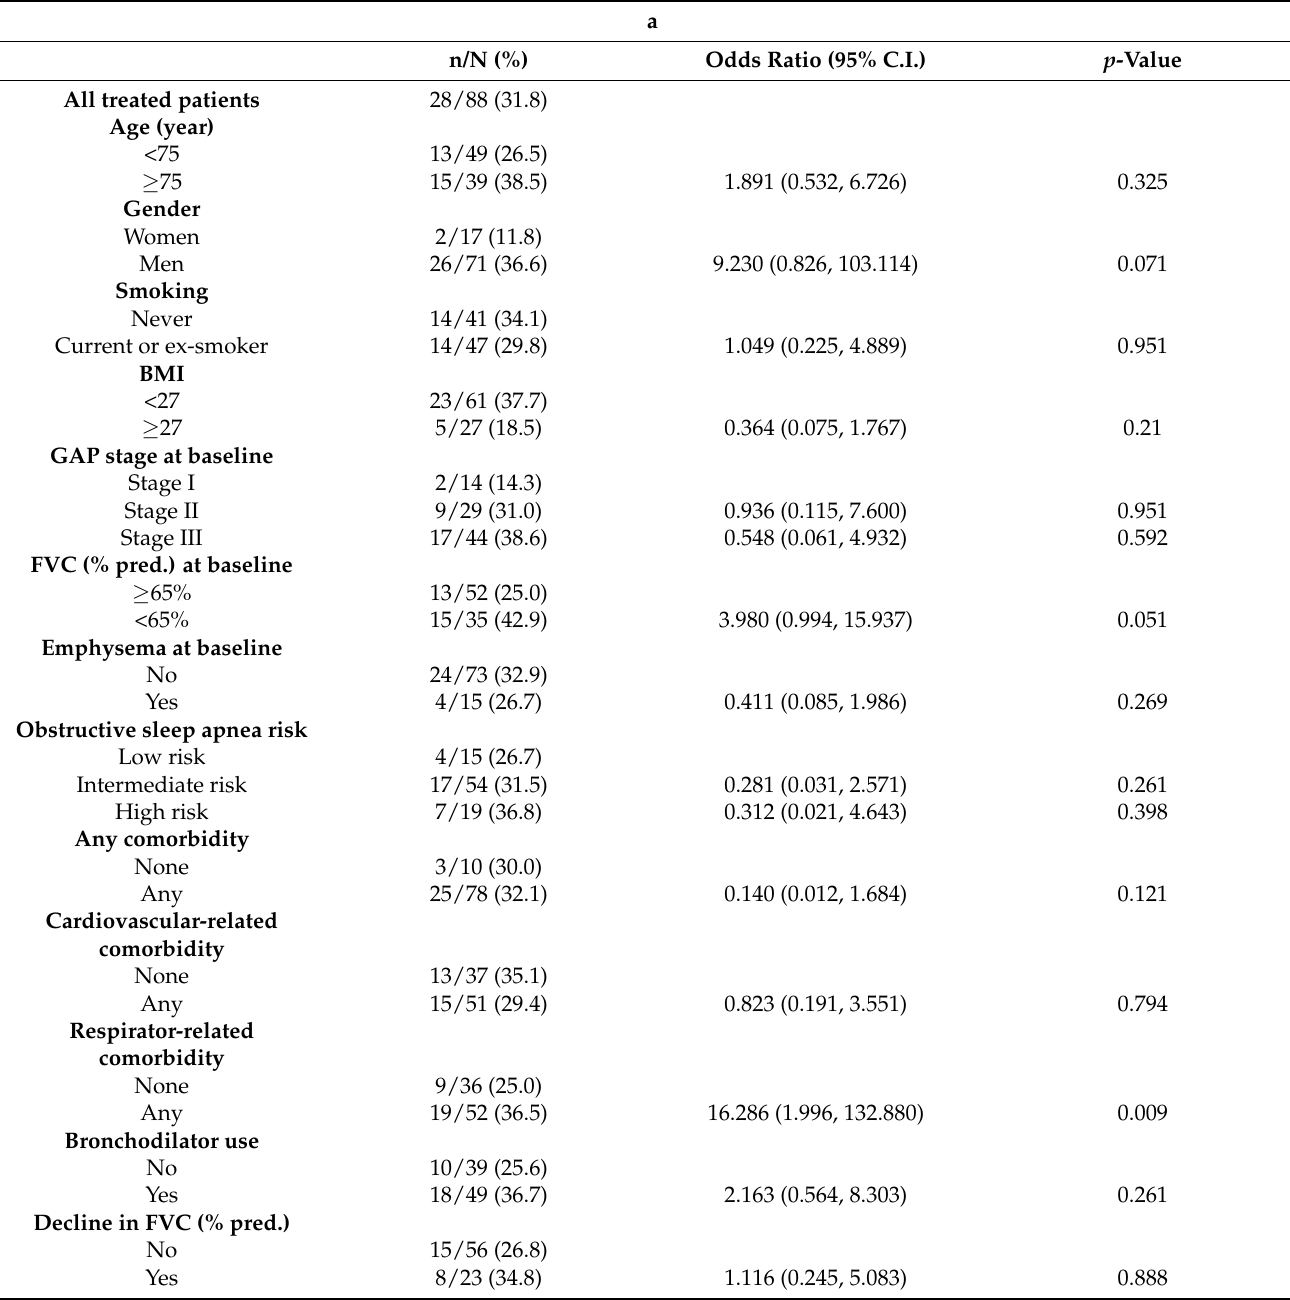
Table 3. Logistic regression analysis for death between weeks